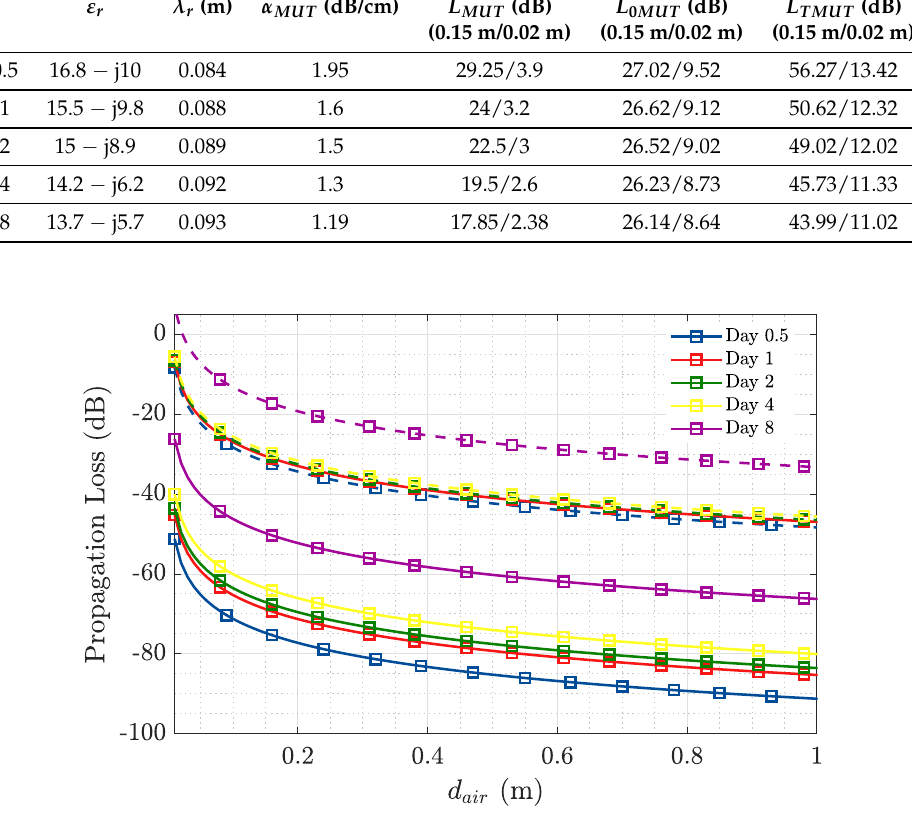
Figure 7. Dynamic range over d air at 868 MHz, for days 0.5, 1, 2, 4, and 8 of concrete’s setting reaction, for a sensor embedded 0.15 m ( d MUT ) inside concrete (straight lines), and one embedded 0.02 m (dashed